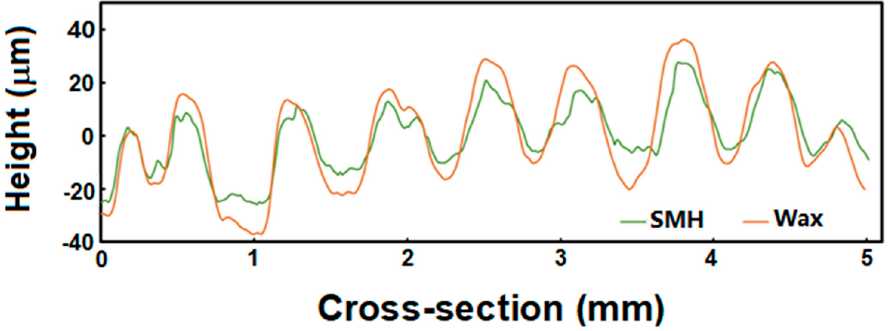
Figure 17. Cross-section profiles of wax and SMH samples.